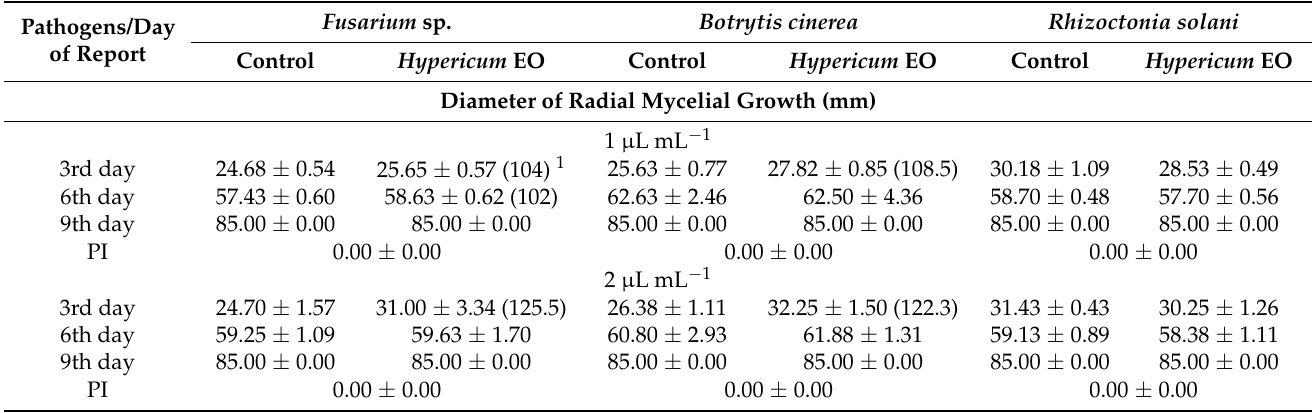
Table 7. Inhibitory effect of commercial Hypericum perforatum essential oils (Com, Bul) on plant pathogenic fungi (mean ±